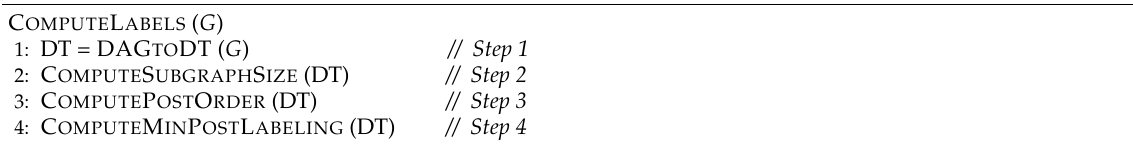
Algorithm 2 The labeling computation phase based on four BFSs. C OMPUTE L ABELS ( G )